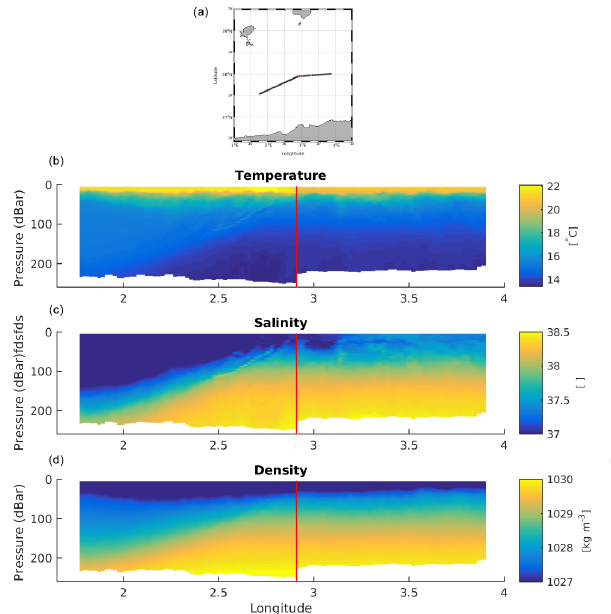
Figure 10. MVP measurements across the FAST station. In (a) , the positions of each MVP cast (and of the FAST station) are shown as black (and red) crosses. Below are shown the sections of tempera- ture (b) , salinity (c) and density (d) .